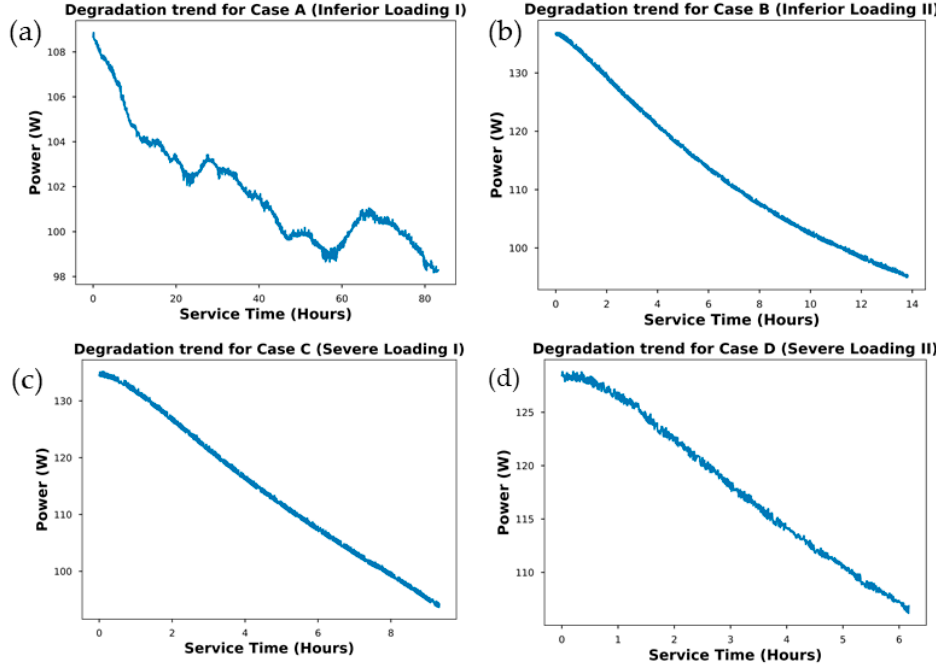
Figure 7. Degradation trend. ( a ) Case A. ( b ) Case B. ( c ) Case C. ( d ) Case D.